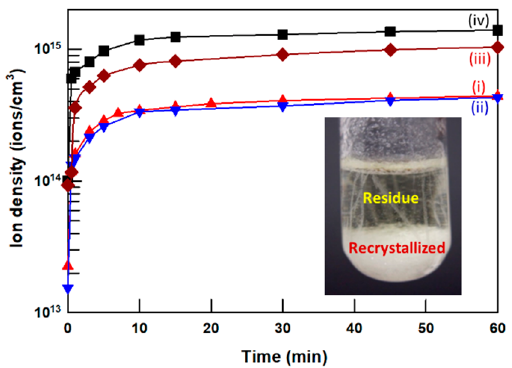
Figure 4. Ion density of (i) a nematic LC mixture (MLC-2079), (ii) a mixture of 10 wt% purified C3M and 90 wt% MLC-2079, (iii) a mixture of 10 wt% residual C3M and 90 wt% MLC-2079 and (iv) a mixture of 1 wt% Irgacure 369 and 99 wt% MLC-2079 during irradiation of 100 mW cm − 2 UV light for 60 min. Inset is an image of the recrystallized solution of C3M monomer.